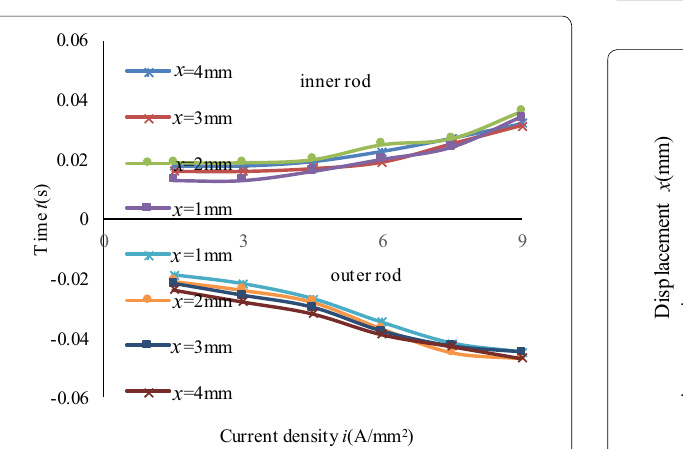
Figure 19 Displacement dynamic curve